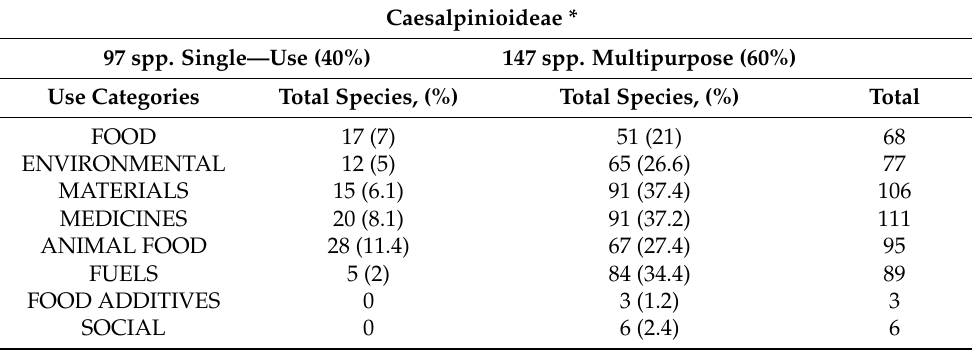
Table 3. Values of eight selected use categories of Caesalpinioideae, calculated percent of a total of 244 species. Categories values are based on Figure S2 (Supplementary Materials). * ca. 95% woody plants. Matrix correlation: r = 0.76391.